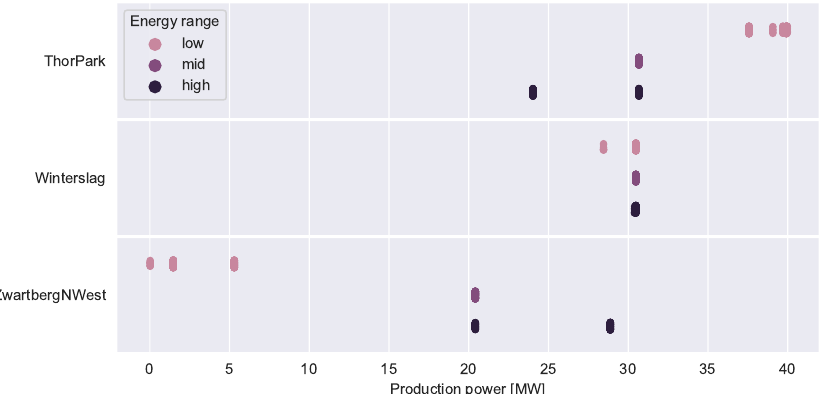
Figure 7. Spread of the nominal power of the chosen production systems, again subdivided according to the range of the energy import from outside the network. The heat pump at Winterslag is nearly always the same size, at ZwartbergNWest the size increases with the range of energy import and the geothermal heating plant decreases with increasing energy range.